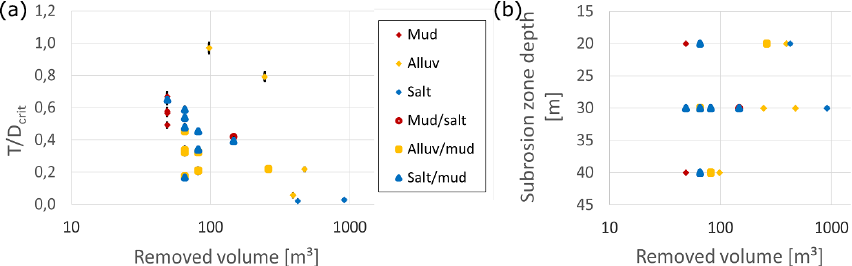
Figure 13. Parameters at the onset of collapse. (a) Thickness to diameter ratio vs. removed volume at the onset of collapse. Note that the T/D crit ratio is either referring to the (stable) subsurface cavity or the (instable) subsurface collapse zone. Red colours stand for mud, orange for alluvial material and blue for salt and the respective multilayer models. (b) Removed volume at the onset of collapse in dependency of the subrosion zone